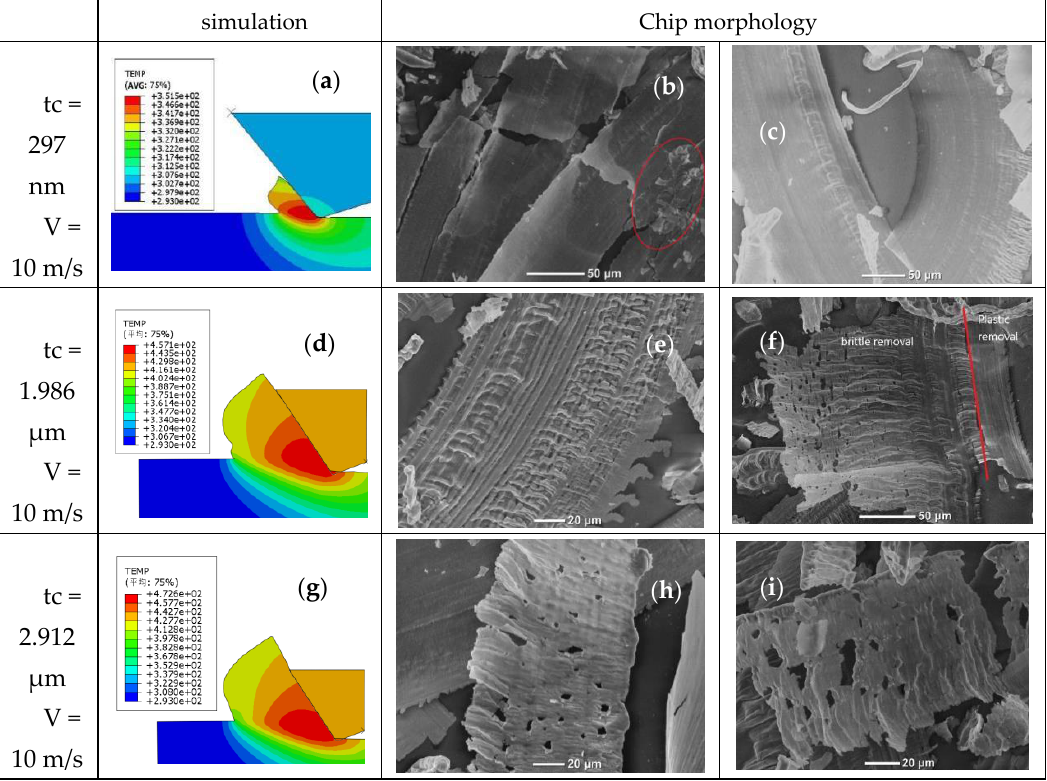
Figure 10. Chip morphology of KDP crystal at different processing stages: ( a )Temperature of tc = 297 nm, V = 10 m/s; ( b , c )Finishing chip morphology; ( d )Temperature of tc = 1.986 μm, V = 10 m/s; ( e , f )semi-finished chip morphology; ( g )Temperature of tc = 2.912 μm, V = 10 m/s; ( h , i )Roughing chip morphology.